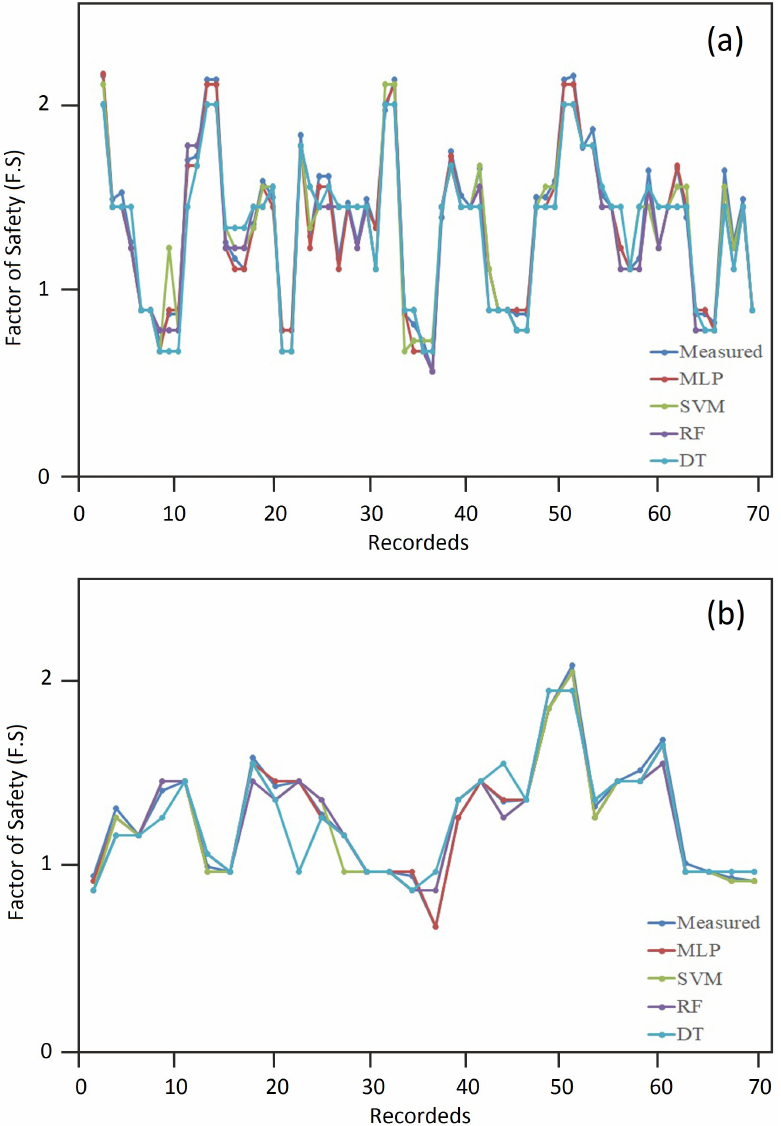
Figure 2. Measured and predicted results’ correlation on different classifiers based on ( a ) training and ( b ) testing sets.